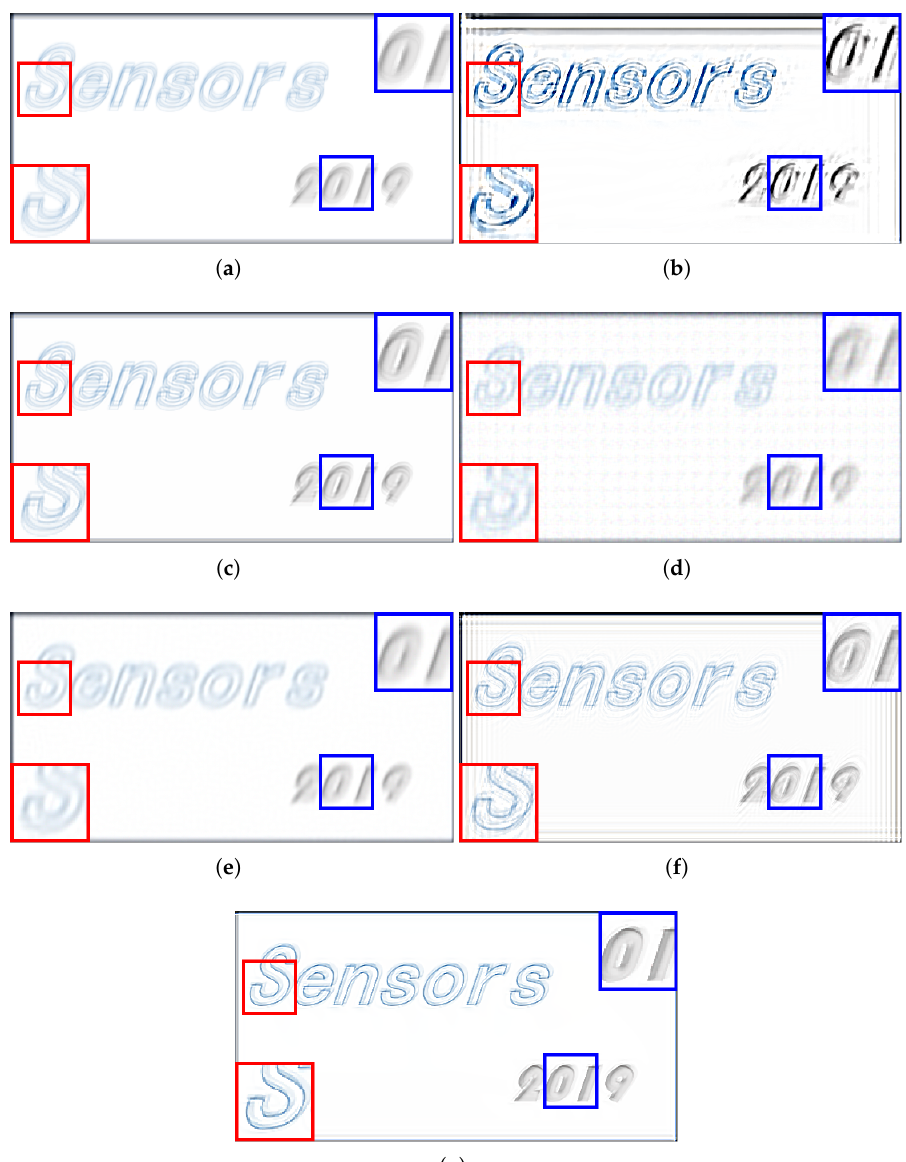
Figure 3. Comparison of different deblurring algorithms using a motion blurred image. ( a ) the input blur image; ( b ) the deblurring result of Xu’s method [33] (peak signal-to-noise ratio (PSNR) = 14.76, structural similarity index (SSIM) = 0.72); ( c ) the deblurring result of Shen’s method [34] (PSNR = 20.06, SSIM = 0.88); ( d ) the deblurring result of Yang’s method [35] (PSNR = 22.26, SSIM = 0.84); ( e ) the deblurring result of Dong’s method [26] (PSNR = 22.01, SSIM = 0.87); ( f ) the deblurring result of Wiener filter (PSNR = 22.98, SSIM = 0.80); ( g ) the deblurring result of proposed method (PSNR = 25.00, SSIM =